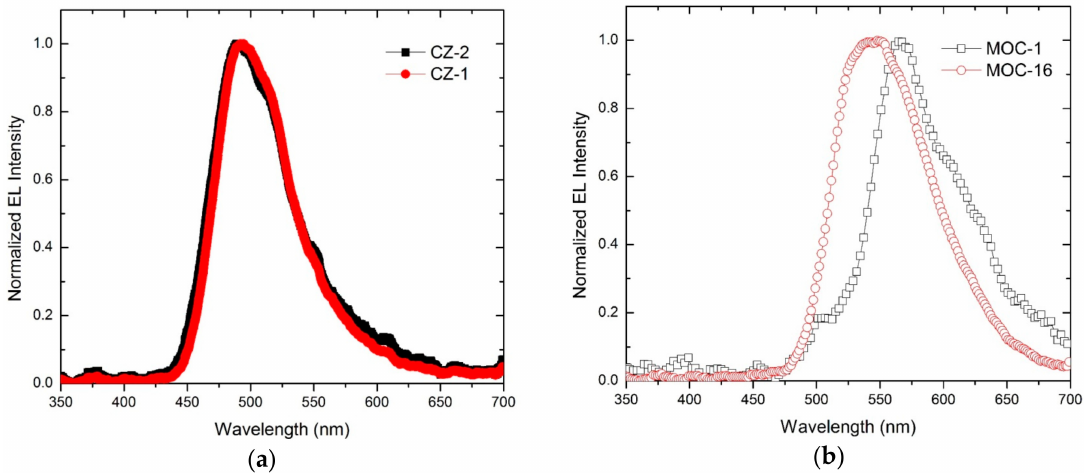
Figure 4. Electroluminiscence spectra of OLEDs based on ( a ) carbazole compounds (CZ-2 and CZ-1) and ( b ) TPD derivatives (MOC-1 and MOC-16) as emissive layers. Current-voltage (J-V) curves and luminances (L-V) of OLEDs based on CZ-2 and CZ-1